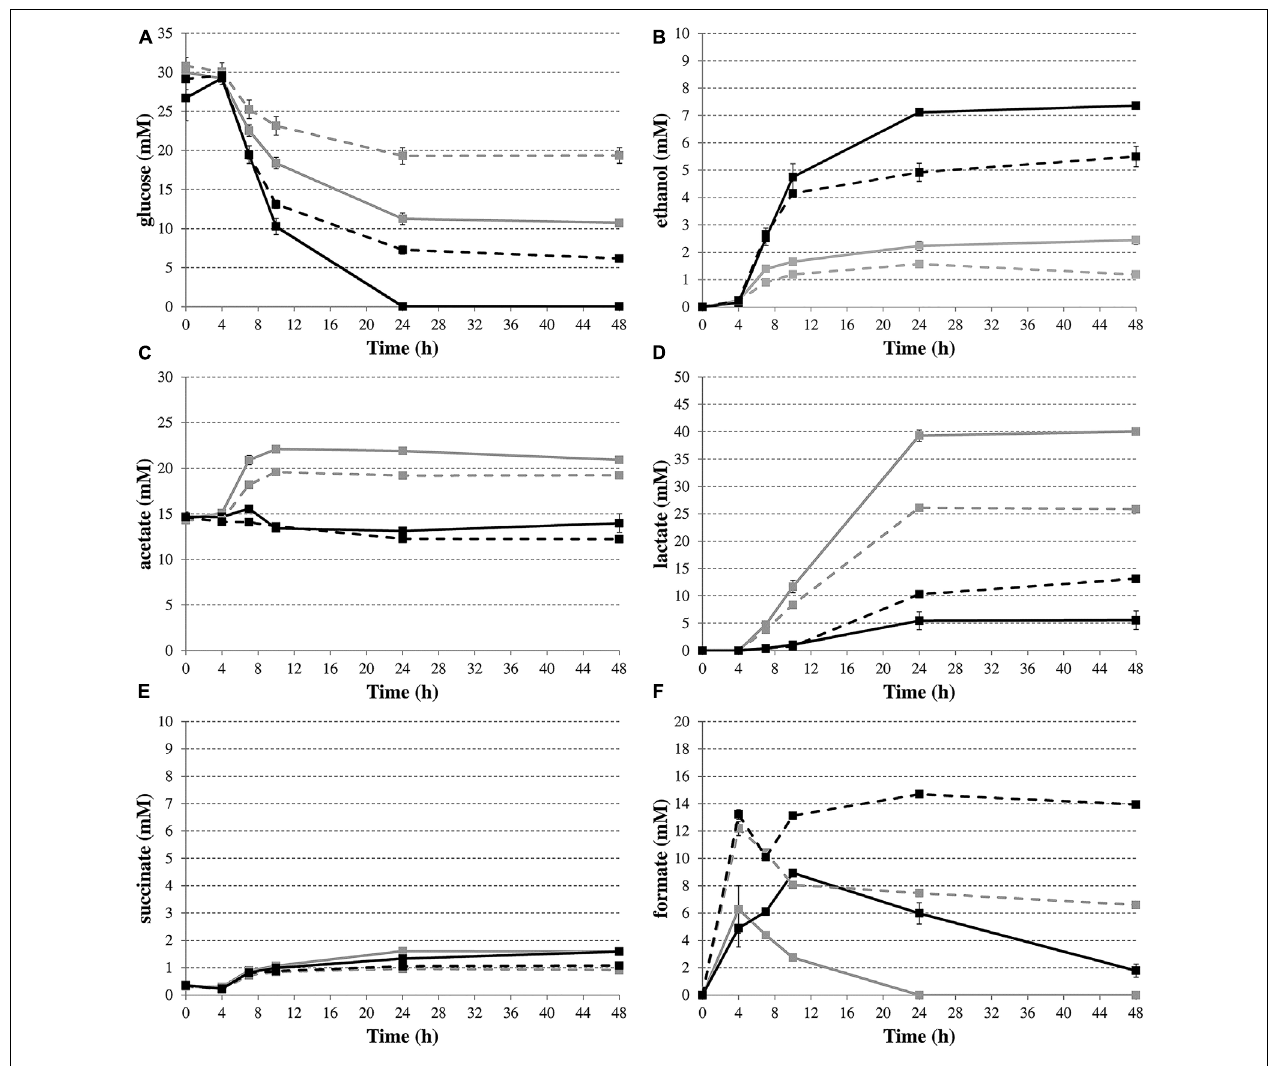
FIGURE 4 |Time profiles of glucose consumption (A) and production of the metabolites ethanol (B), acetate (C), lactate (D), succinate (E), and formate (F) during fermentative growth of E. coli MG1655 wild-type